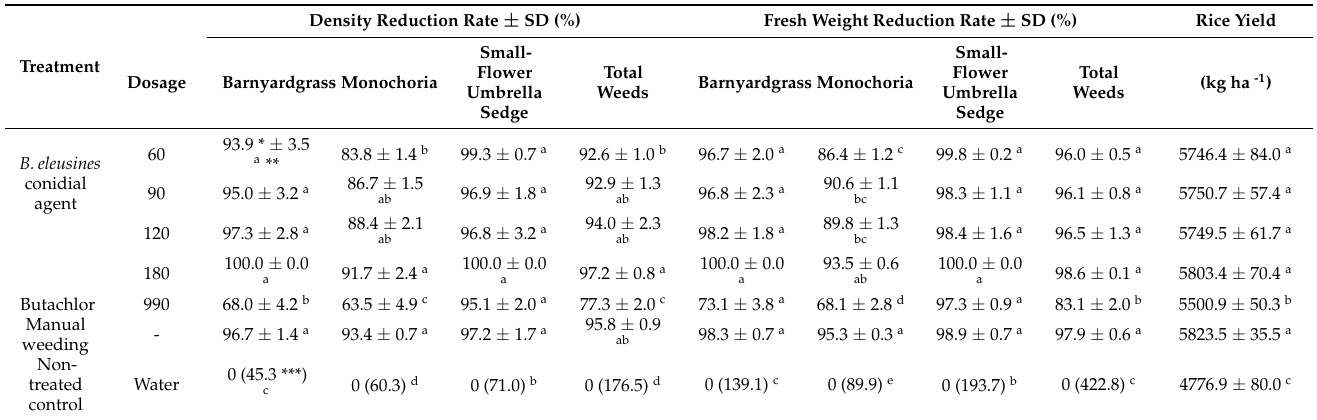
Table 4. Effects of B. eleusines agent with herbicides on weed control and rice yield at Shanghai Seed Breeding Center in 2012.